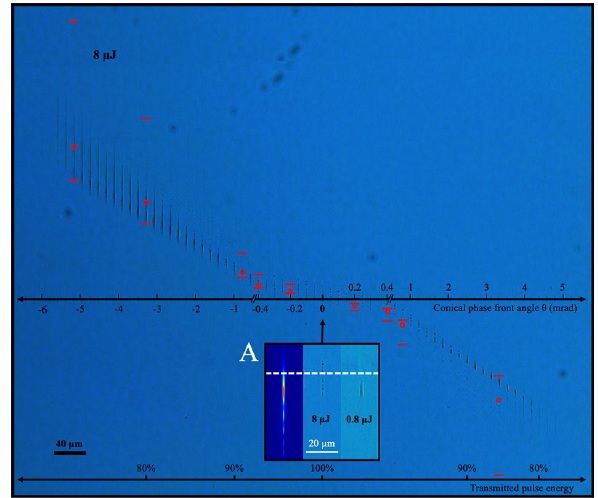
Figure 4. Laser modification tracks formed in fused silica by focussed Gaussian-Bessel beams with varying conical phase front angle. Sequence of modification tracks recorded under backlighting optical microscopy, generated in fused silica at 600 µm focal depth with single laser pulses of 8 µJ energy. The influence of beam shaping scales left to right as a function of conical phase front angle from − 6.6 to + 5.6 mrad. The horizontal axis marks the peak intensity position under surface aberration for the unmodified beam (θ = 0). Red circles and dashes indicate peak intensity and full width at half maximum intensity points, respectively, simulated for conical phase front angle. The bottom horizontal axis marks a reduction of the net energy transmittance through the 6f beam delivery system due to occlusion by apertures and mirrors with increasing magnitude of conical beam angle. The inset (A) compares the low (0.8 µJ) and high (8 µJ) pulse energy modification tracks with the simulated intensity profile expected under surface aberration for the unmodified Gaussian beam ( θ = 0). The white dashed line marks the 600 µm deep, paraxial focal